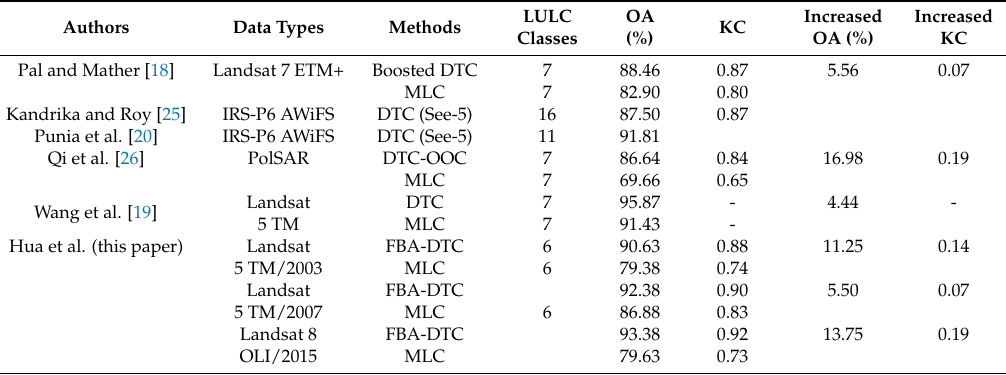
Table 6. Summary of major studies employing decision tree classification